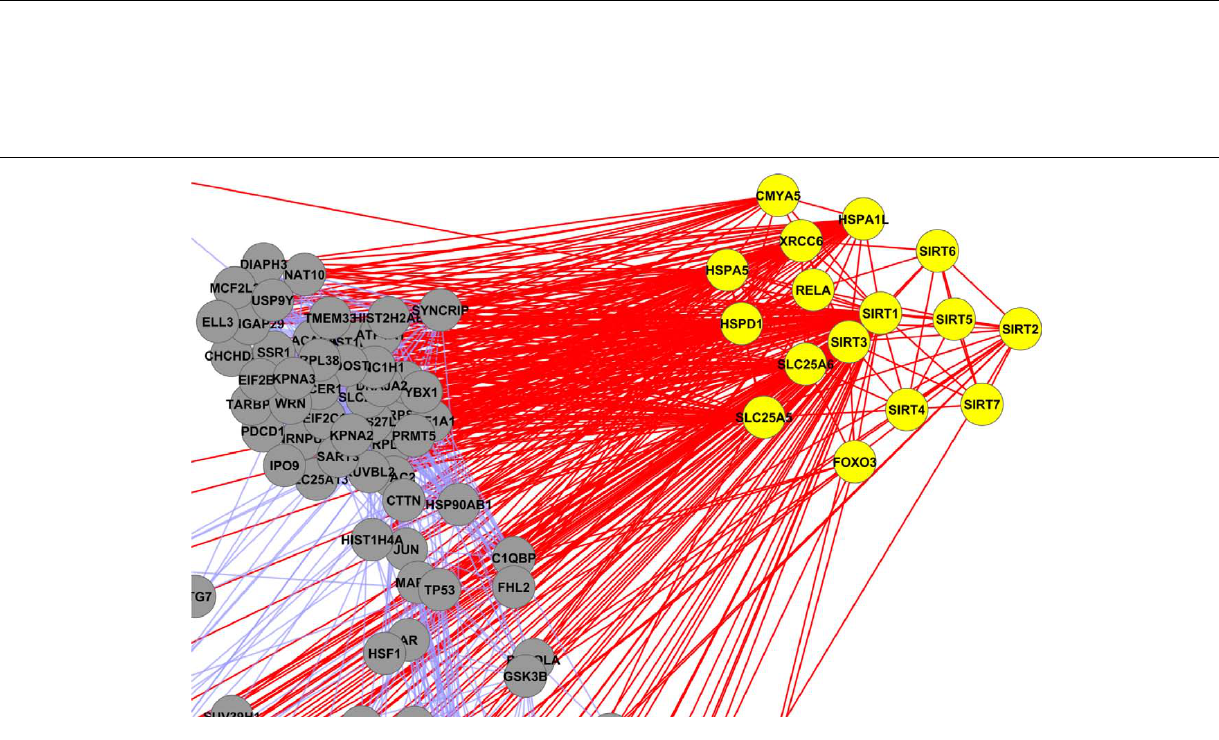
FIGUREA8 |Yellow colored nodes are showing the interaction of mitochondrial sirtuins (Sirt-2, Sirt-3 and Sirt-4).